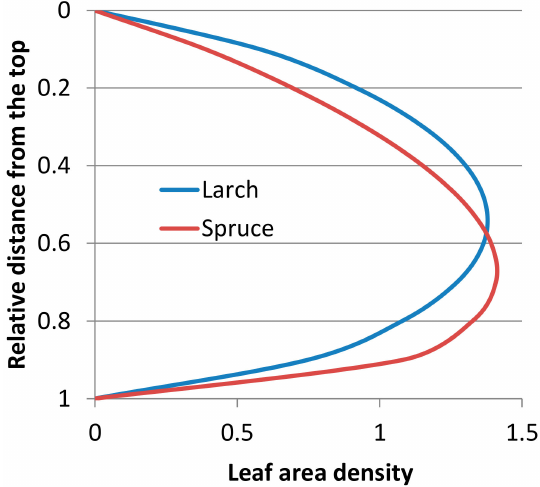
Figure 3. The predicted vertical distribution of the leaf area by